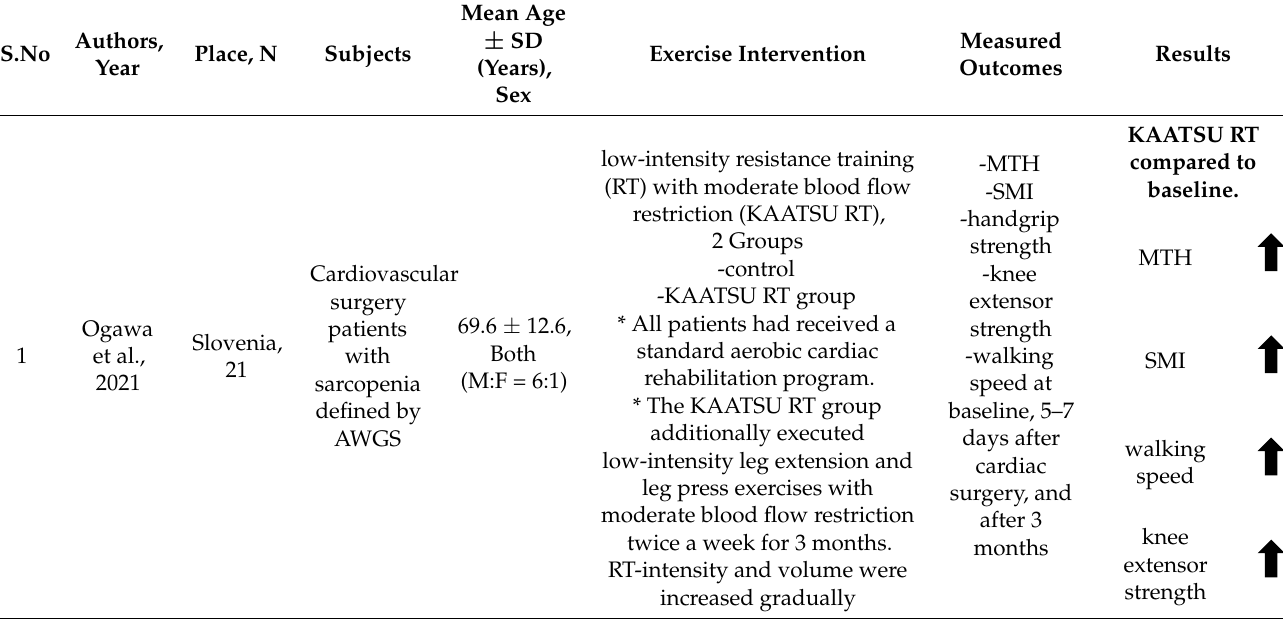
Table 6. Effect of exercise on subjects with sarcopenia and heart diseases. Table 1. Effect of exercise on subjects with cancer and baseline measurement of sarcopenia.